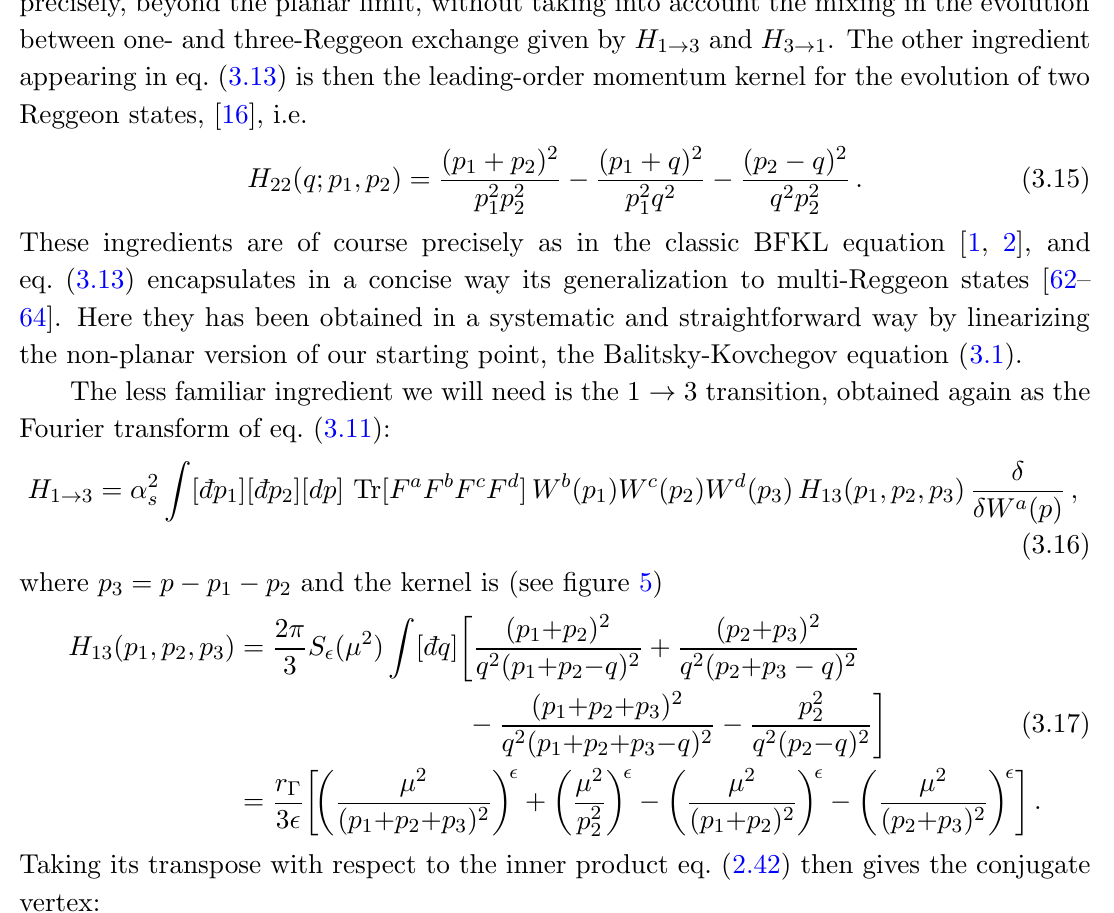
Figure 5 . Diagrams representing the kinematical structure of the 1 the factor H 13 ( p 1 ; p 2 ; p 3 ) in eq. (3.17). The hamiltonian H 13 ( p 1 ; p 2 ; p 3 ) is derived in the context of an e(cid:11)ective (cid:12)eld theory in 2 be thought as e(cid:11)ective vertices. The actual colour structure associated to the 1 evolution is given by the diagrams in (cid:12)gure